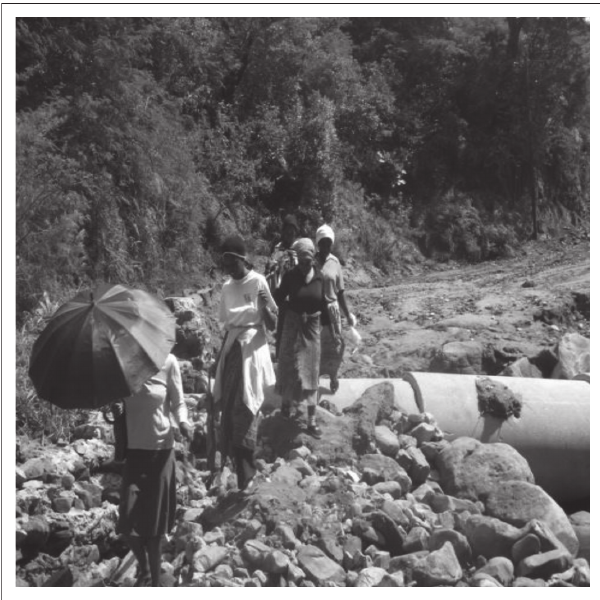
FIGURE 5: Damage to road and culvert (Road D3688) – Tshilungwi Village.